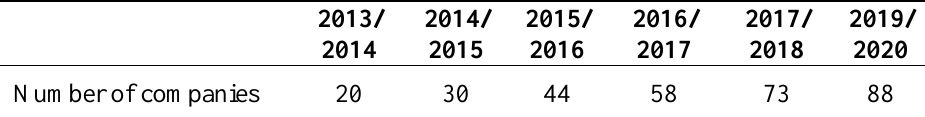
Table 2: Year-wise